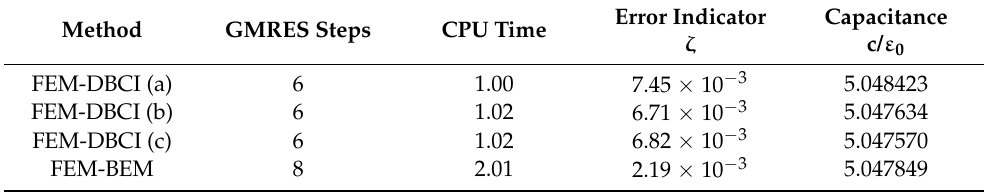
Table 2. Comparison between various FEM-DBCI and FEM-BEM for the 2nd